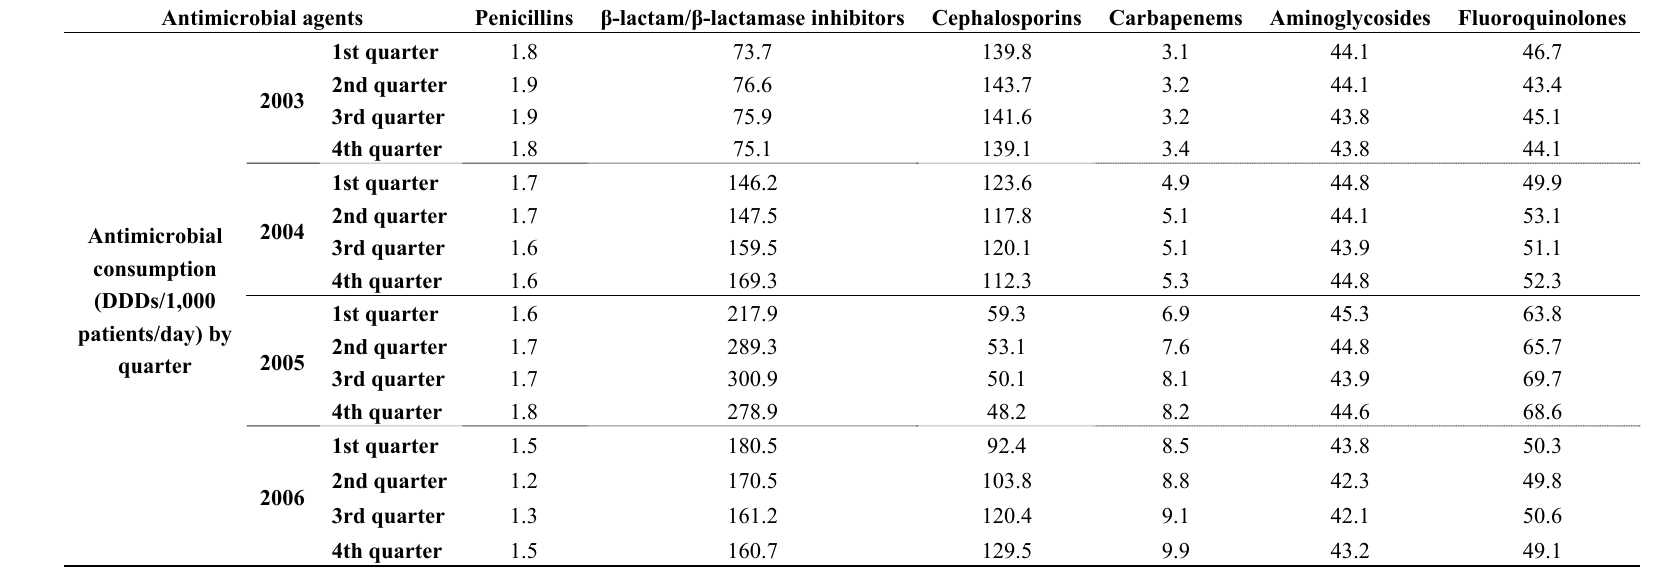
Table 3. Correlation between quarterly consumption of antimicrobial agents and rates of CRAB in First Hospital of Jilin University, 2003–2011. Antimicrobial